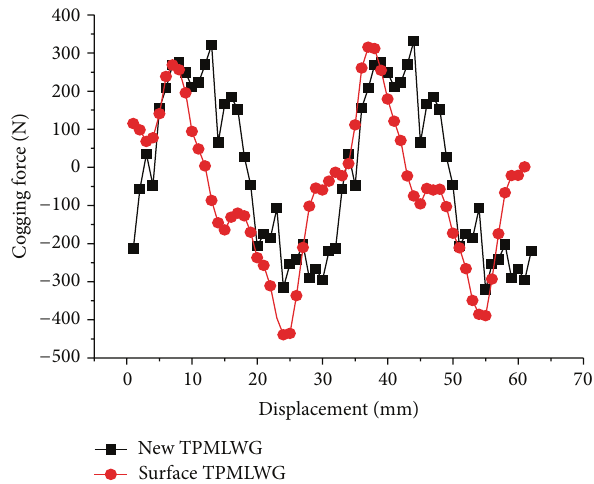
Figure 8: Waveform of air gap flux density and harmonic analysis: (a) the air gap flux density of TPMLWG and (b) the harmonic analysis of